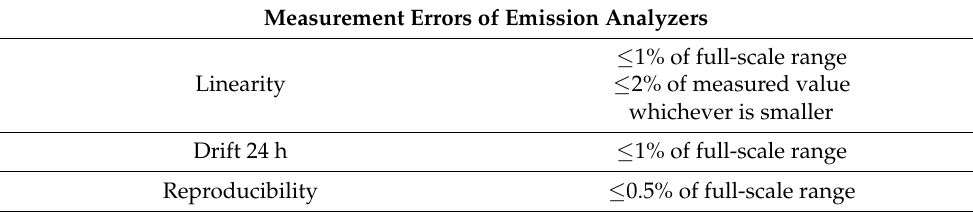
Table 3. Manufacturer’s data for the measurement errors of emission analyzers.